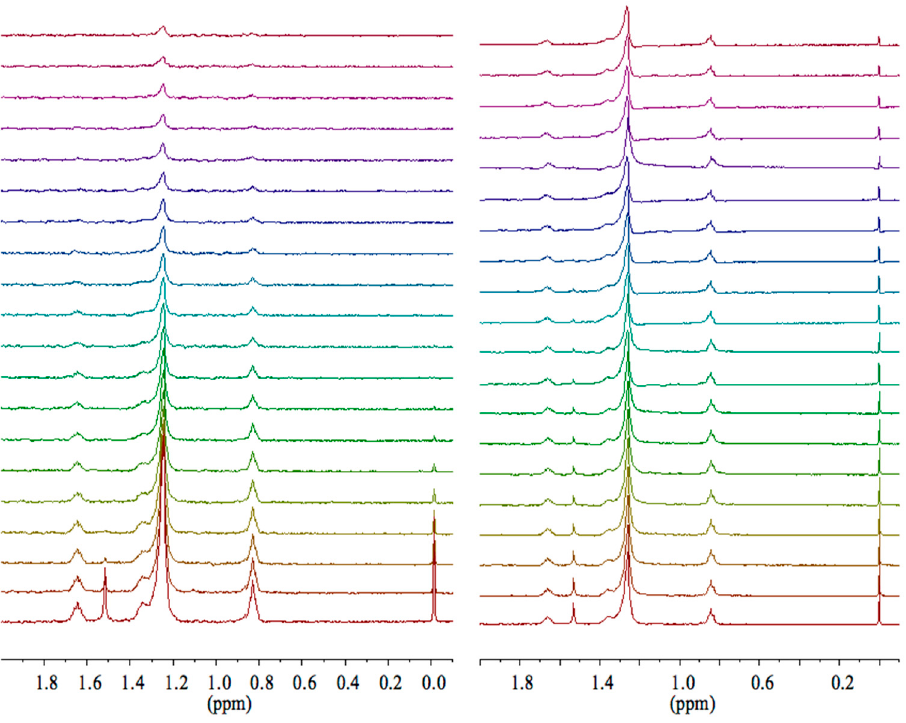
Figure 5. PGSTE-NMR spectra of 1.85 molar ratio SDS / CTAB solutions, collected at 30 °C, with Δ = 60 ms (left) and Δ = 10 ms (right). PGSTE, pulsed gradient stimulated echo.